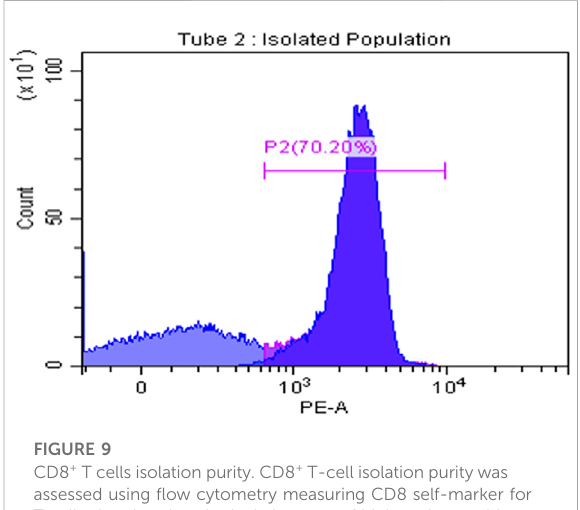
FIGURE 9 CD8 + T cells isolation purity. CD8 + T-cell isolation purity was assessed using fl ow cytometry measuring CD8 self-marker for T cells showing that the isolation was of high purity reaching 70.20%.